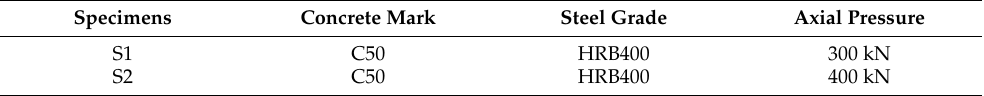
Table 2. Specific parameters of specimens.